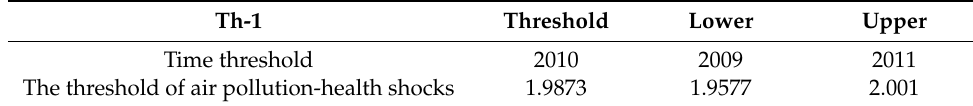
Table 8. The estimation of single threshold point.